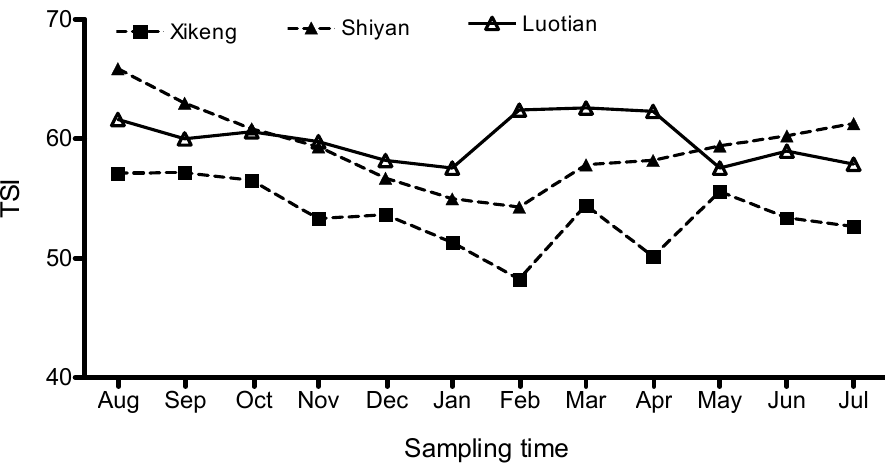
Figure 2. Trophic state index (TSI) value in the three reservoirs from August to July.